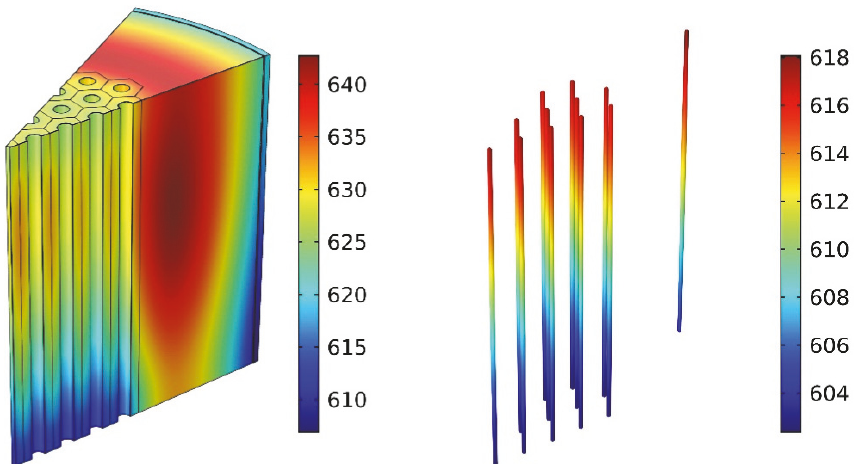
Figure 7: Temperature distribution in the solid region (left) and fuel salt (right) (unit: ∘ C).